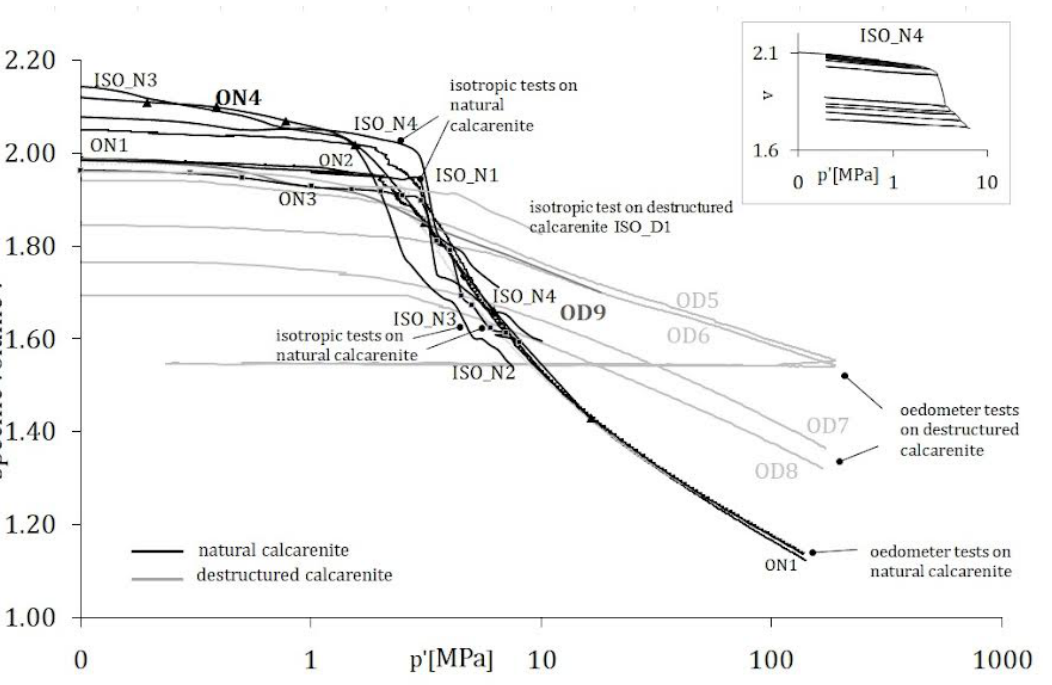
Figure 3. Isotropic and 1-D compression curves for natural and destructured samples of lithotype B2.